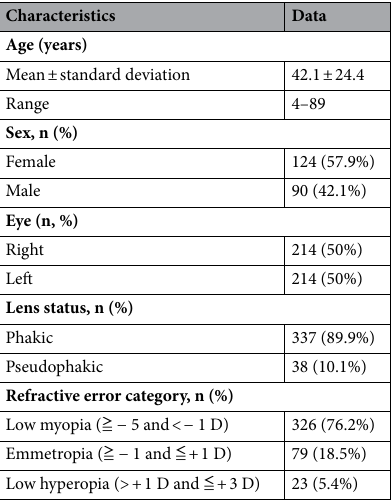
Table 1. Baseline clinicodemographic characteristics of subjects. Data on age and sex are listed for subjects, and data on lens status and refractive error category are listed for eyes. D